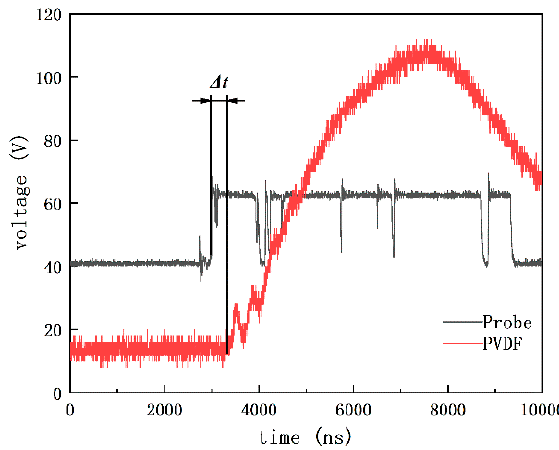
Figure 18. The signals detected by the probe and polyvinylidene fluoride (PVDF).